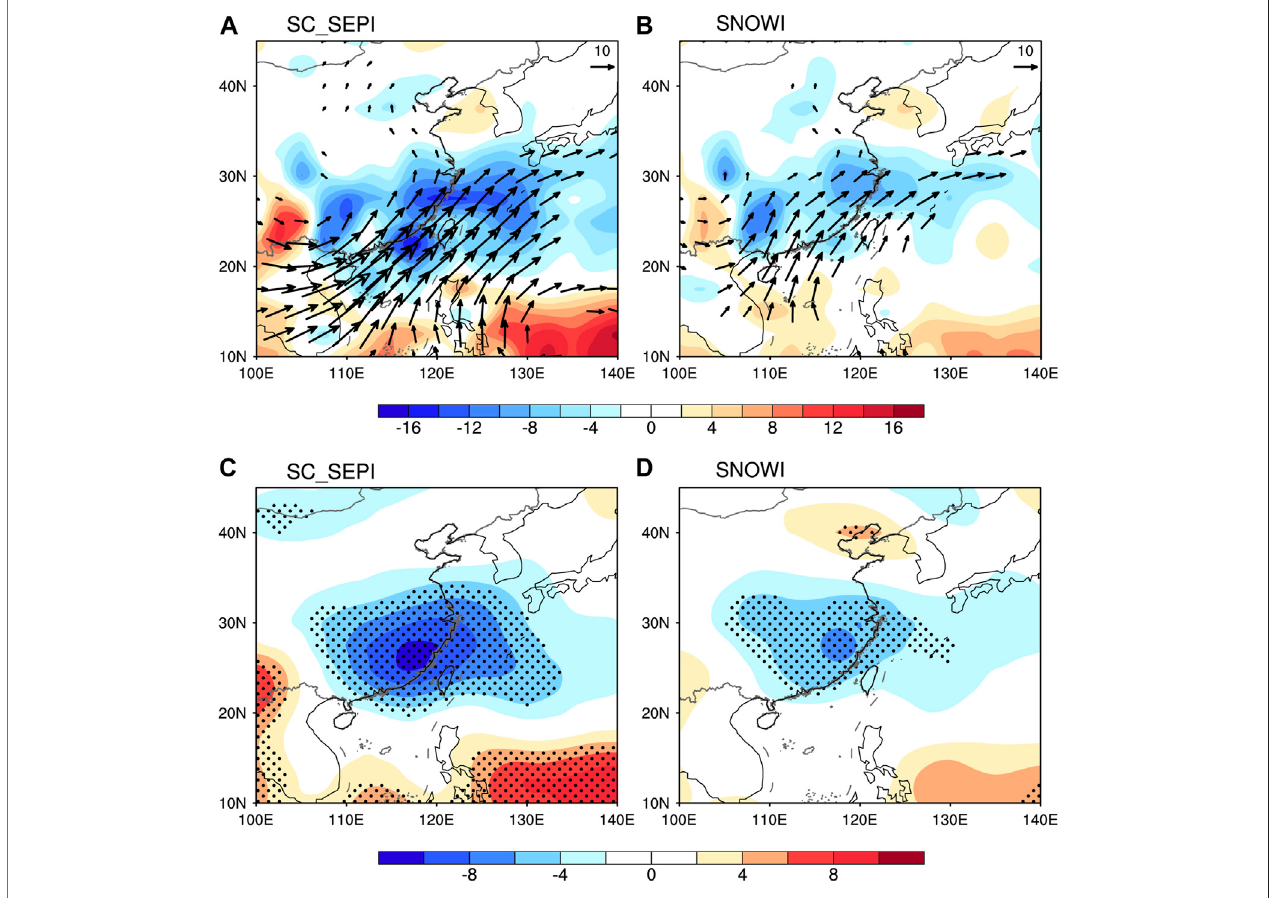
FIGURE 3 | Regressions of spring (A) vertically integrated water vapor fl ux (vectors; kgm − 1 s − 1 ) and its divergence (shading; 10 − 6 kgm − 2 s − 1 ) and (C) 500 hPa verticalvelocity(10 − 3 Pas − 1 )againsttheSC_SEPIduring1979 – 2017. (B) and (D) arethesameas (A) and (C) butfornegativeOctoberSNOWI.Stippledregionsindicate that the anomalies are signi fi cant at the 95% con fi dence level. Vectors that are signi fi cant at the 90% con fi dence level are shown.